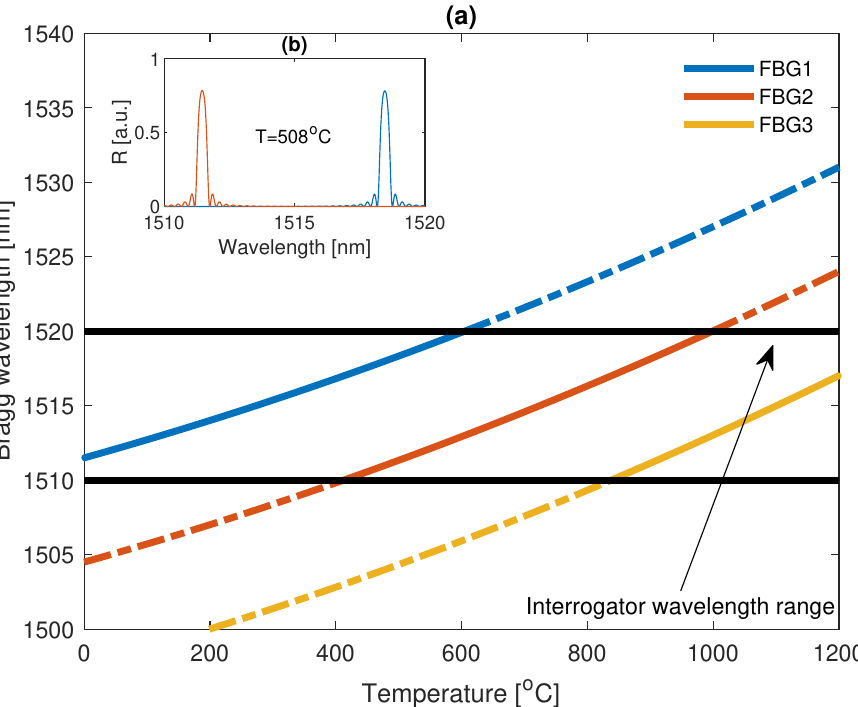
Figure 8. Concept of bypassing the limits of an optical interrogator. In ( a ), a relation between the Bragg wavelengths of the FBG sensors and the temperature acting on the fiber is shown. In ( b ), an example of a spectrum of two sensors for a temperature equal to 508 ◦ C is